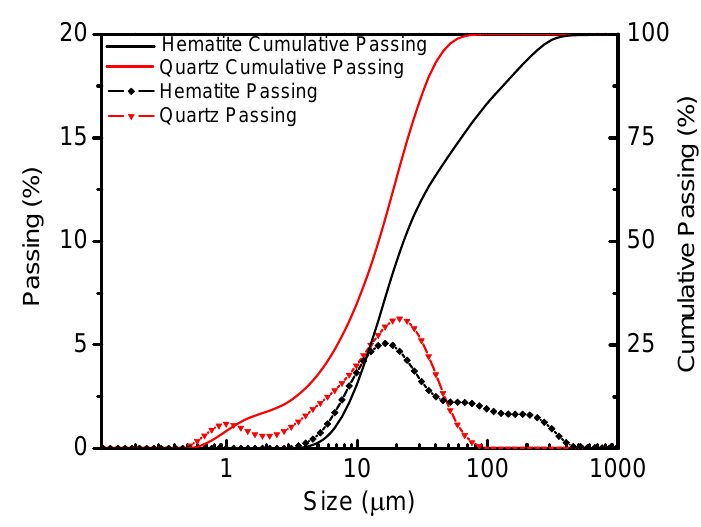
Figure 2. Size distributions of hematite and quartz particles.